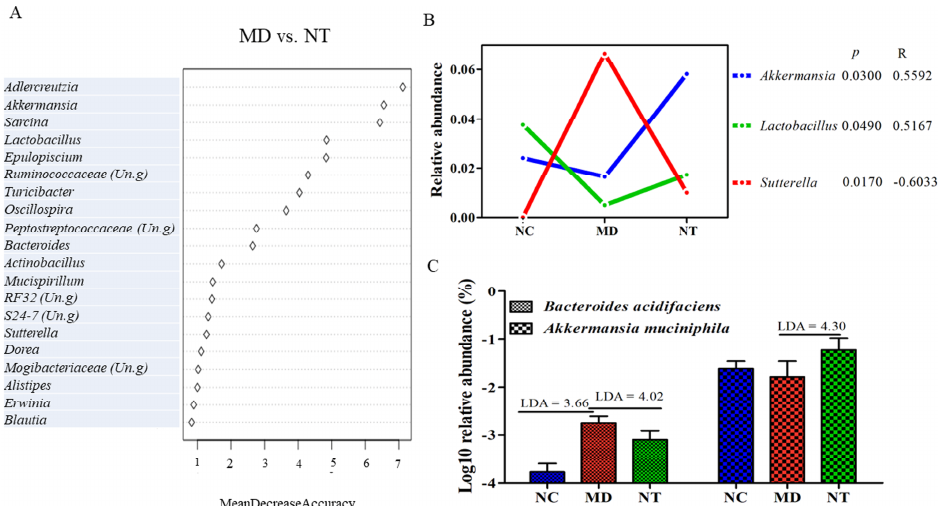
Figure 4. Bacterial species and genera significantly impacted by neoagarotetraose (NT). A : The most